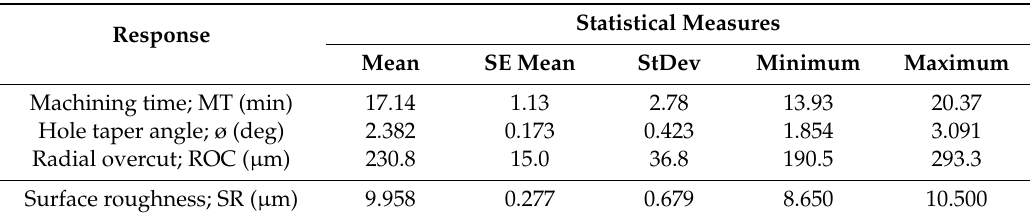
Table 7. Statistics of machining